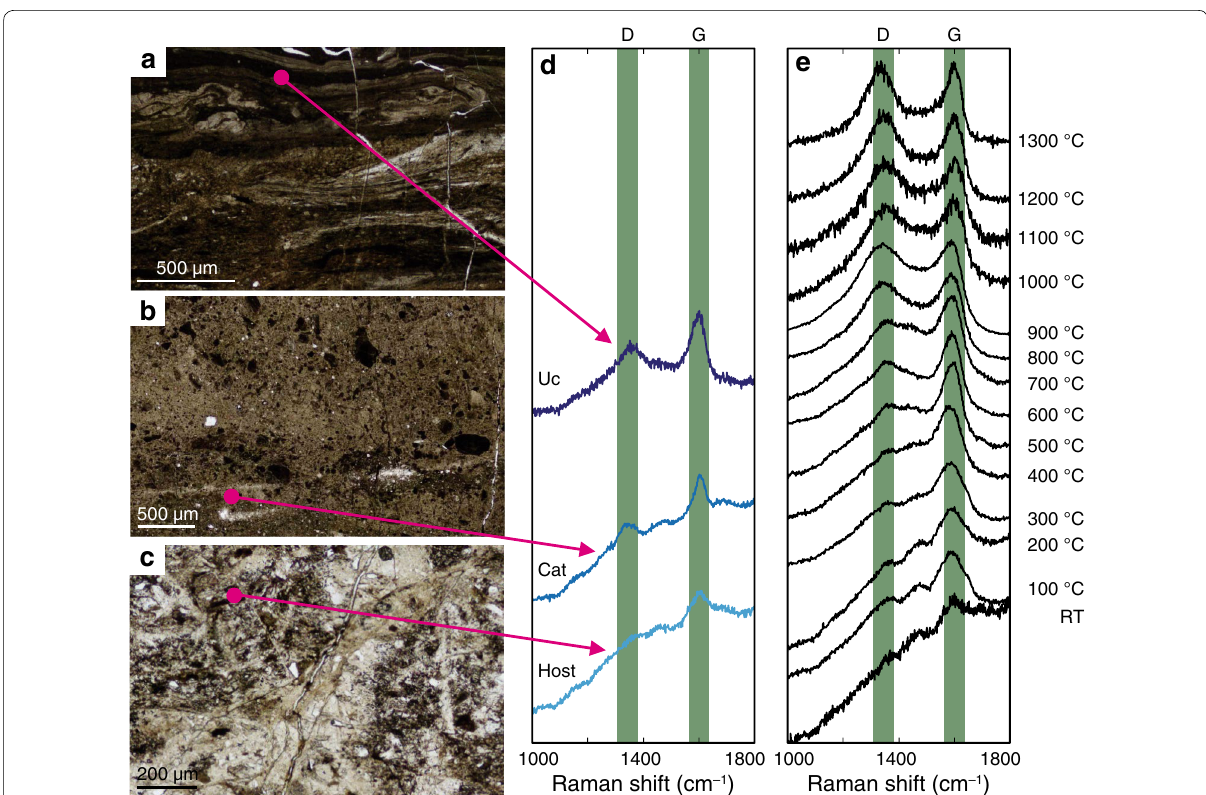
Fig. 4 Locations of CM analytical points (red circles) in the Emi major thrust (see also Fig. 3a). a Ultracataclasite, b cataclasite, and c host rock. d Rep- resentative Raman spectra of CM samples. e Raman spectra of experimentally heated CM extracted from host rock. D, disordered band; G, graphitic